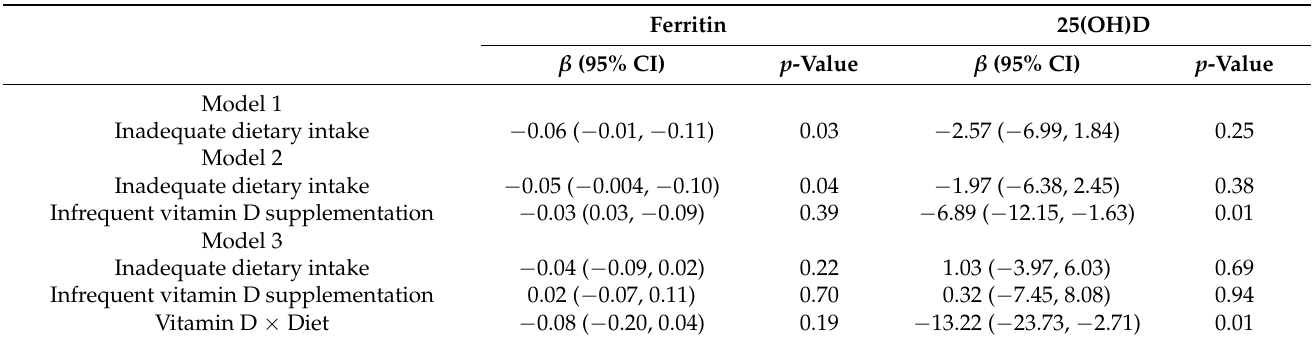
Table 4. Associations of vitamin D supplementation frequency and diet status with serum 25(OH)D and ferritin concentrations among pregnant women.